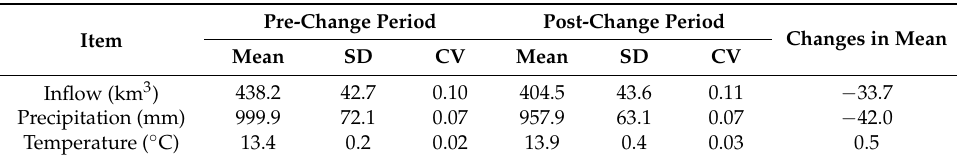
Table 1. Characteristics of the annual inflow, precipitation, and temperature before and after change point.